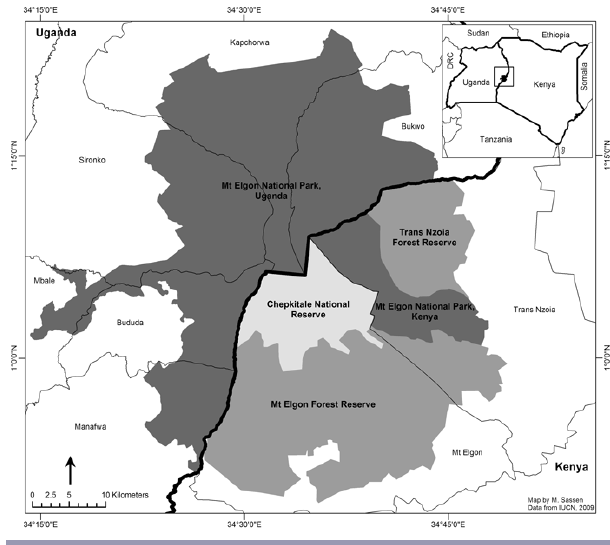
Fig. 2 . The Mt. Elgon area in Uganda and Kenya and the respective protected